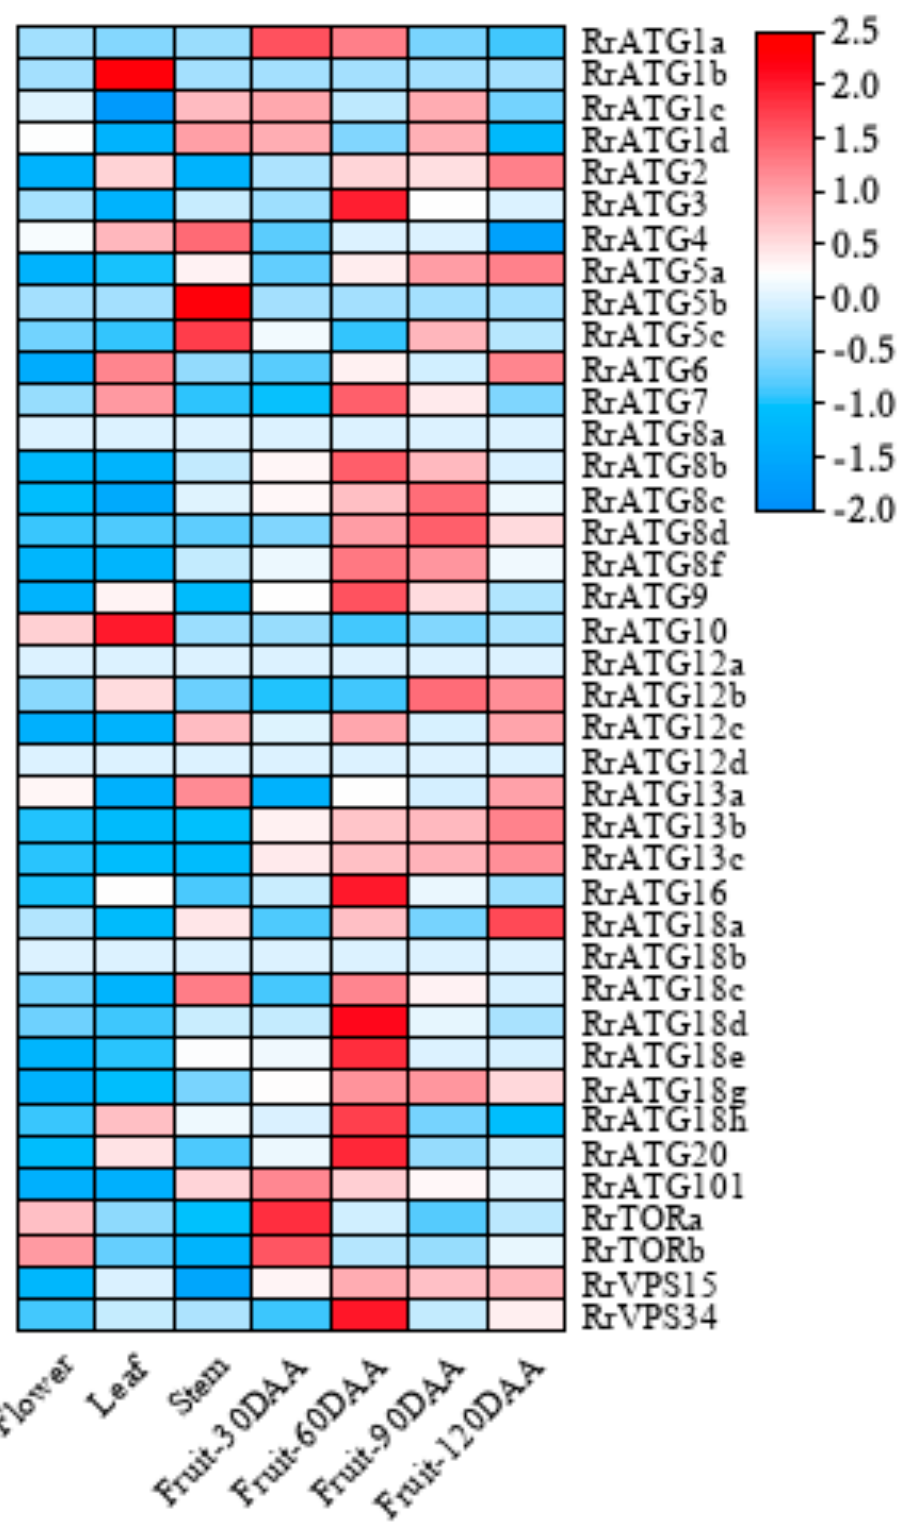
Figure 4. Expression patterns of RrATGs in different tissues and different fruit developmental stages. Raw data from genomic RNA-seq databases in R. roxburghii . DAA was represented days after anthesis. Red and blue represent the higher and lower expression levels in each row,